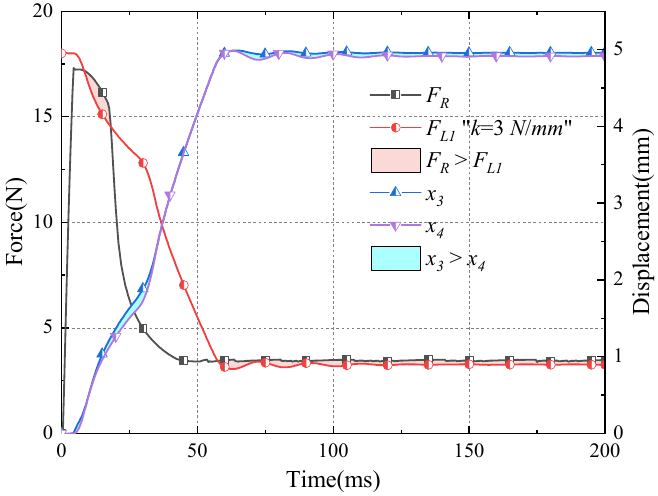
Figure 19. The relationship between force and displacement. It is shown in Figure 19 that the F L curve is always above the F R curve when the stiffness of the pilot spring k ≥ 4 N/mm, ensuring F L ( t ) > F R ( t ) in the process of opening. In other words, the pilot outlet valve is reliably closed during the opening process of the proportional valve, and the system remains stable. Under the 5 mm step signal, the F L and F R curves are shown in Figure 15 when k ≤ 4 N/mm, and the red shaded part is F L < F R . Then, there will be a displacement difference between the displacement curve of the main inlet valve and the displacement curve of the pilot outlet spool after a certain delay time. It is expressed with blue shade in Figure 20. The final displacement of the main inlet valve spool is 4.95 mm, and there is a 0.05 mm displacement difference between the main inlet valve spool and the pilot inlet valve